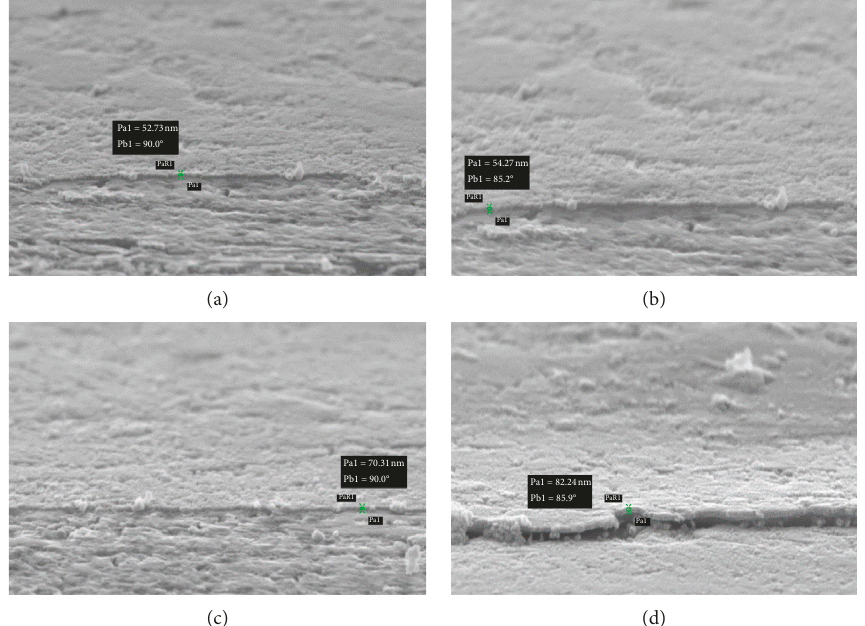
Figure 7: SEM images of electrophoretic deposition with (a) 20-, (b) 30-, (c) 40-, and (d) 60-minute deposition the nucleation site density remains almost constant with As shown in equation (9), the surface superheat tem- changing of the contact angle at averaged time period. perature or the heat transfer coefficient depends on the nucleation site density, bubble departure diameter, and bubble departure frequency. Phan et al. [23] observed that